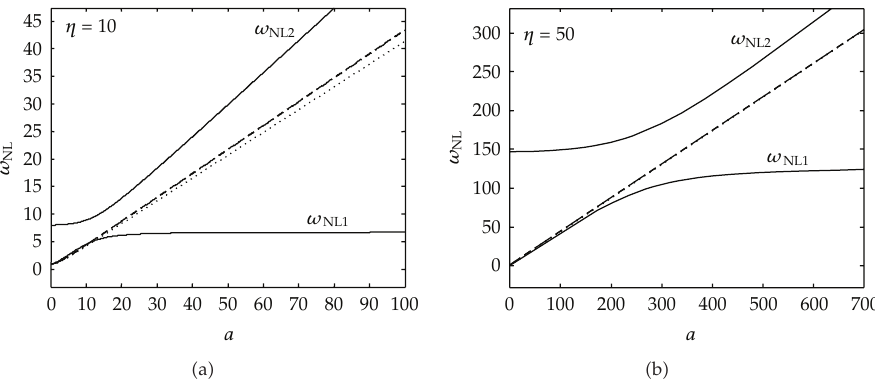
Figure 3: Nonlinear frequency versus nondimensional amplitude (cid:2) - - - (cid:3) Bernoulli-Euler’s, (cid:2) ··· (cid:3) Rayleigh’s, (cid:2) –-– (cid:3) shear, and (cid:2) — (cid:3) Timoshenko’s Beam